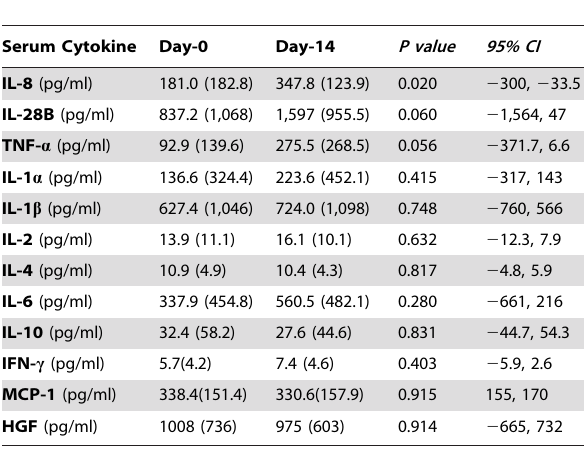
Table 6. Effects of Pioglitazine on serum cytokines.